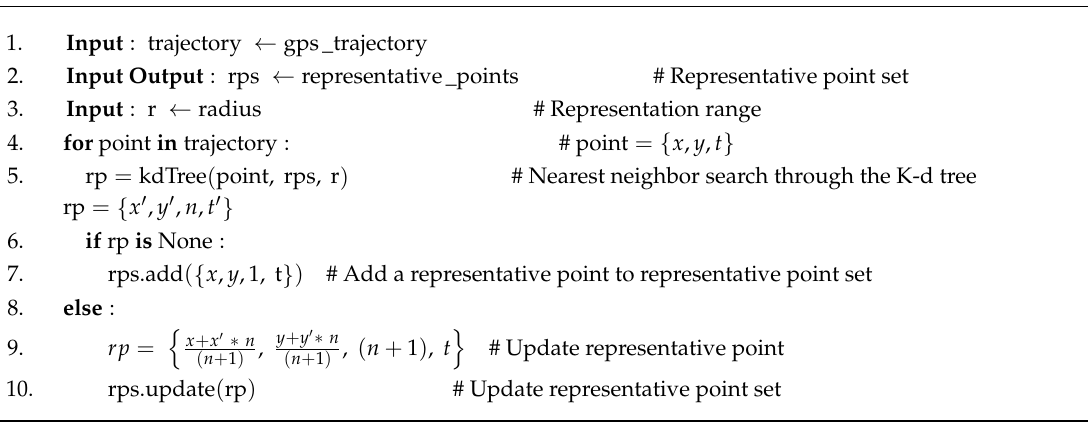
Algorithm 1 Representative point extraction and updating